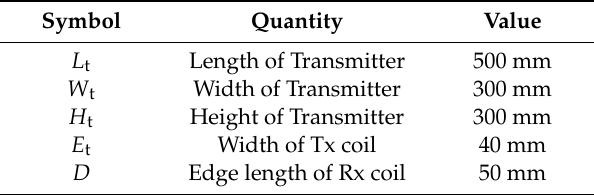
Table 1. Optimal dimensions of the experimental prototype.